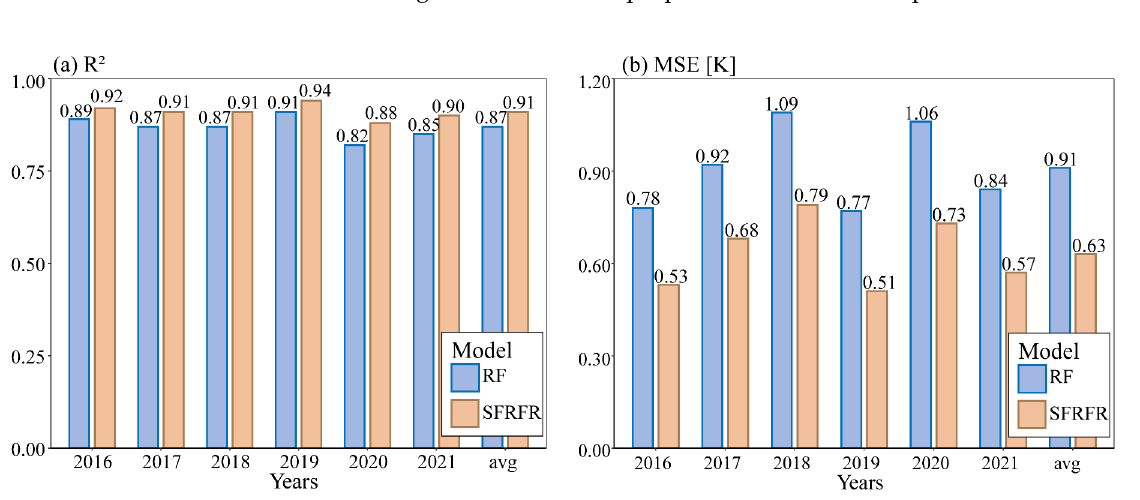
Figure 10. Spatial distribution of the reconstructed summertime LST from 2016 to 2021.